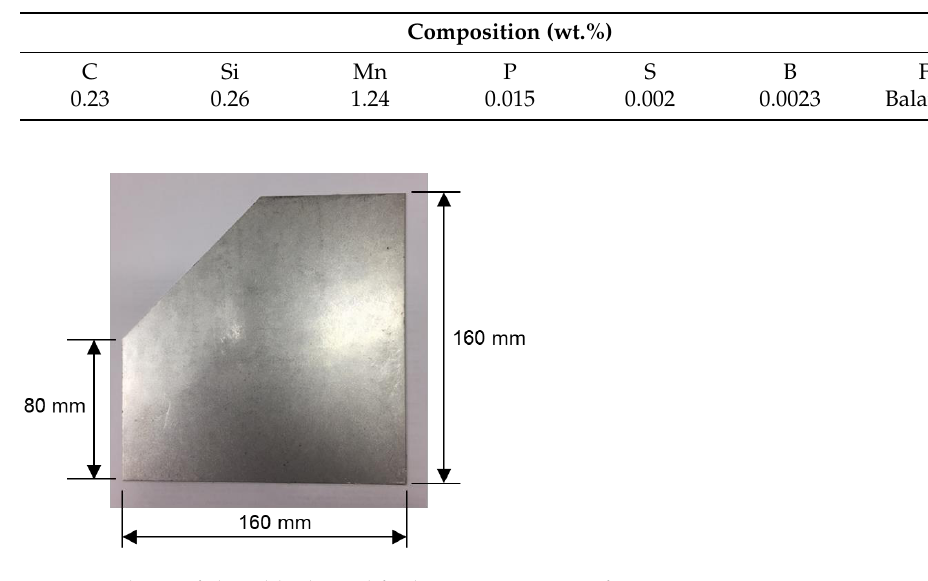
Figure 2. Shape of sheet blank used for hot stamping test of T-type part.